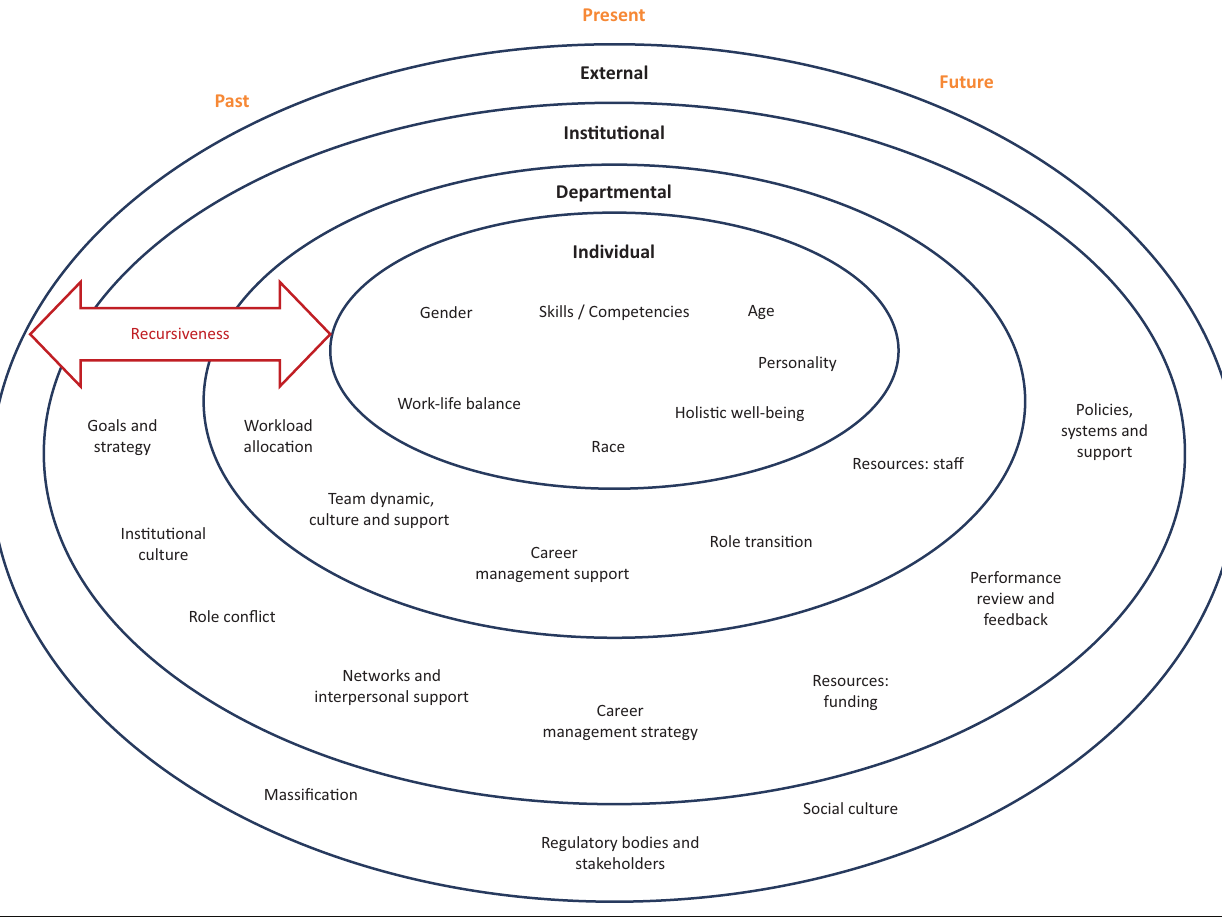
FIGURE 2: Findings structured into four themes as aligned to the systems-thinking